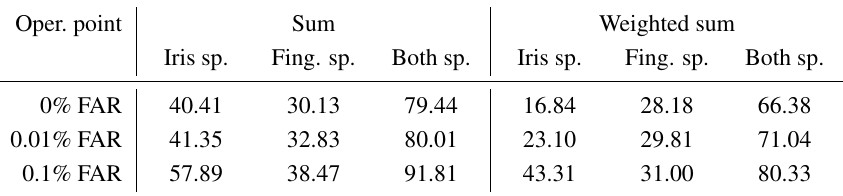
Table 4. FAR (%) of the iris–fingerprint system in parallel fusion mode, with the sum and weighted sum using worst-case spoof attack assumption, when either the iris, the fingerprint or both the iris and fingerprint are spoofed, at three operating